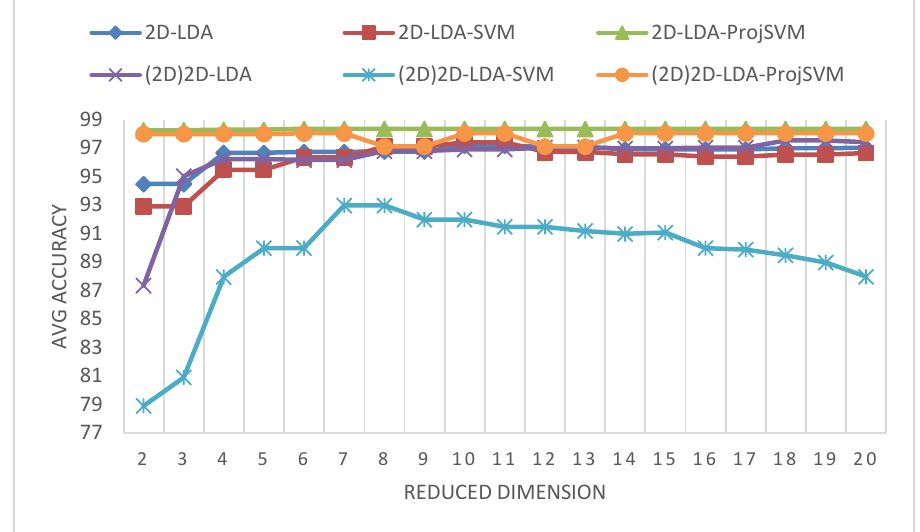
Figure 4. Average accuracy versus reduced dimension for six methods on JAFFE dataset with LDA-based